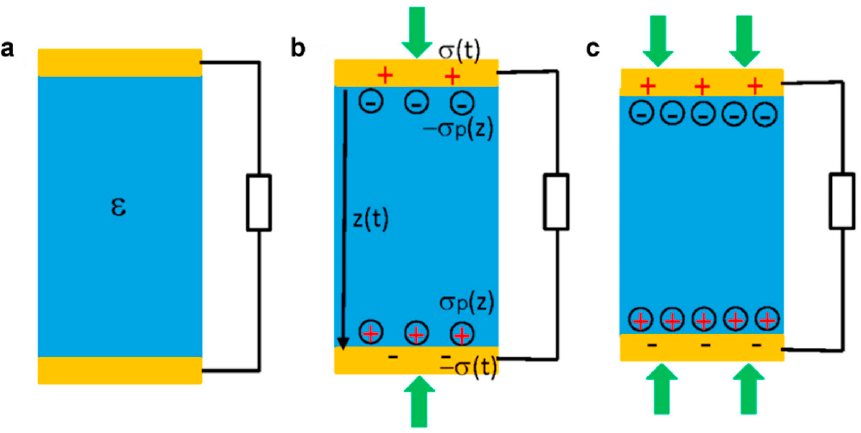
Figure 2. The working principle of a piezoelectric nanogenerator (PENG): ( a ) An insulator piezoelectric material is covered by top and bottom electrodes on its two surfaces. ( b ) A vertical mechanical deformation results in the generation of piezoelectric polarization charges at the two ends of the material. ( c ) An increase of the applied force results in higher polarization charge density [34].